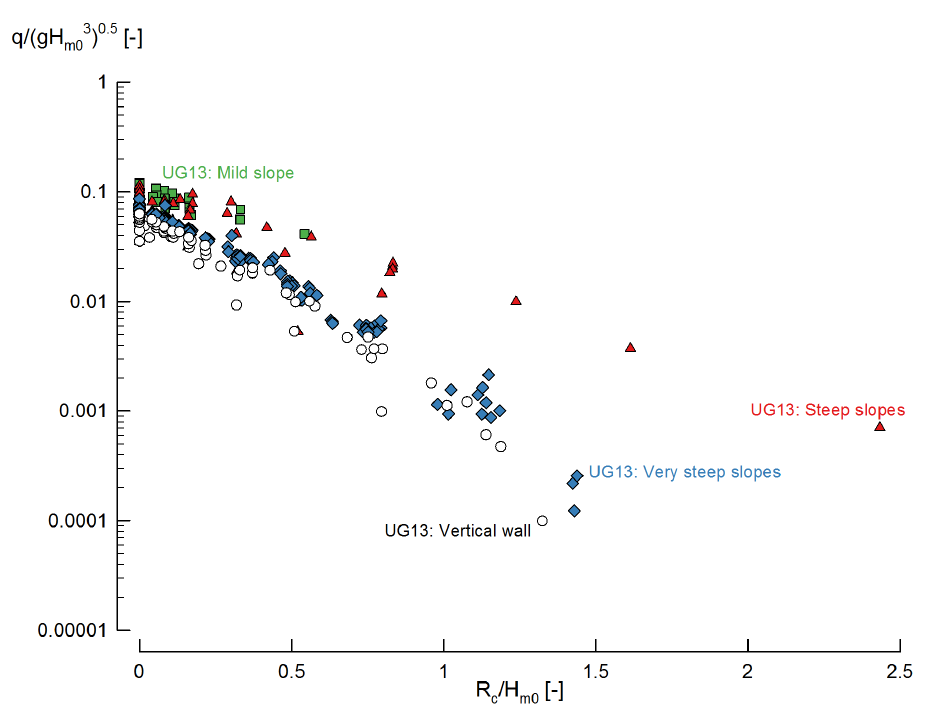
(cid:113) gH 3 as a function of the relative crest m 0